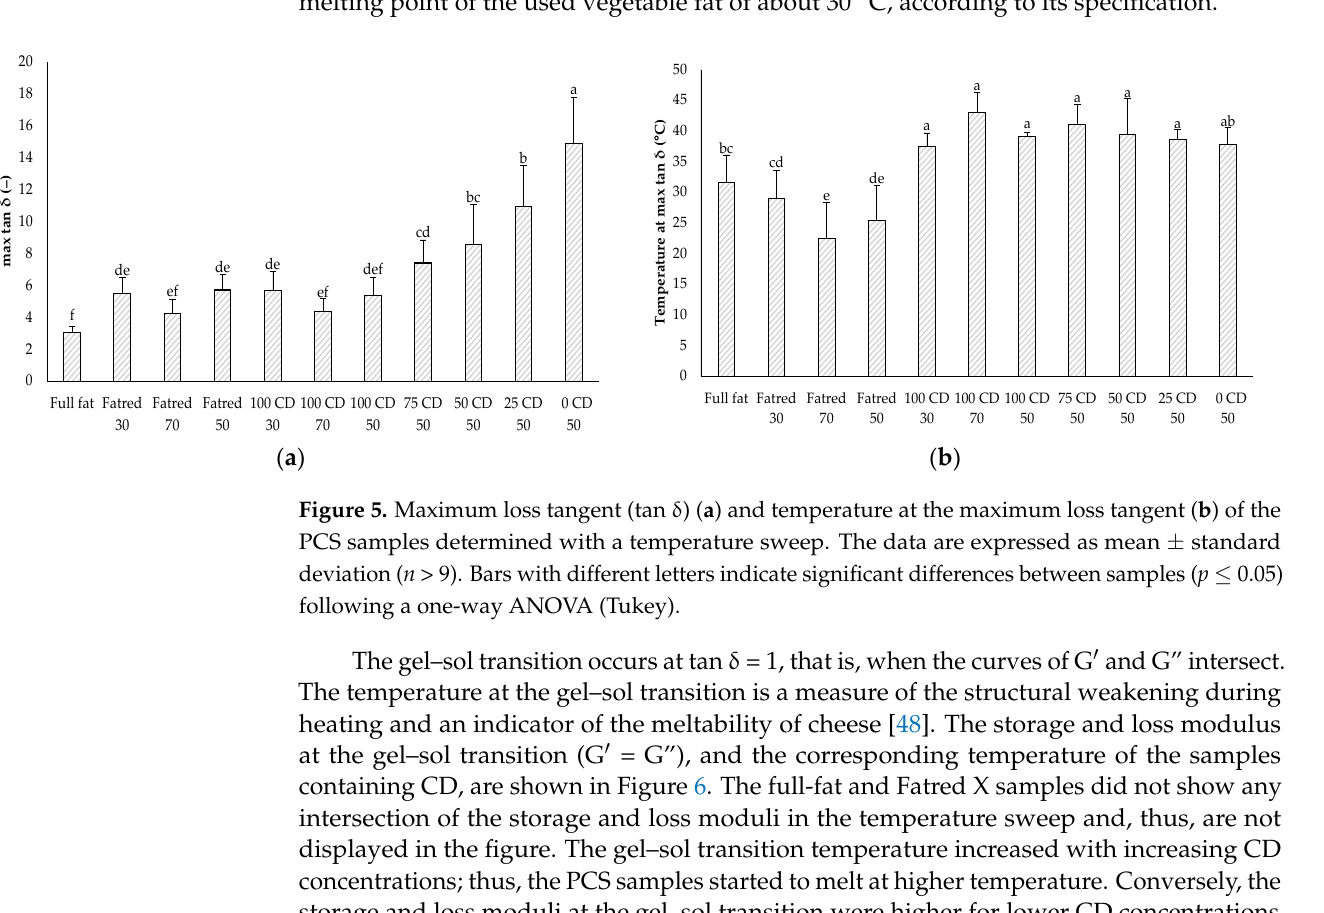
Figure 6. G ′ and G ″ at gel – sol transition temperature ( a ) and gel – sol transition temperature ( b ) of the PCS samples measured with a temperature sweep. The data are expressed as mean ± standard deviation ( n > 9). Bars with different letters indicate significant differences between samples ( p ≤ 0.05) following a one-way ANOVA (Tukey).